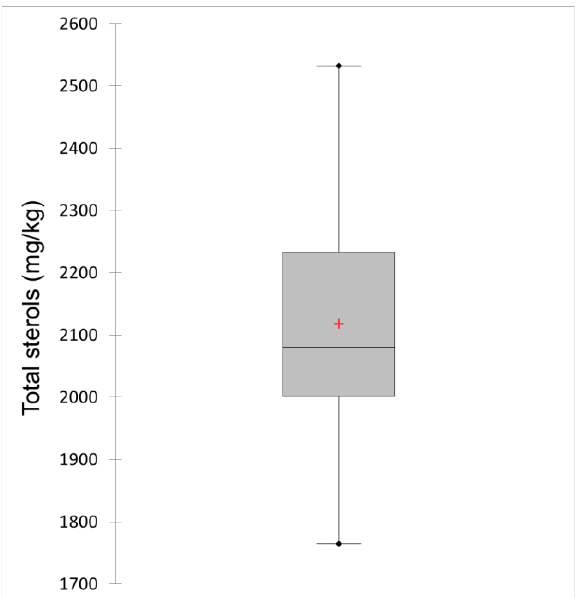
Figure 1. Box-whisker plot of total sterol content in the analysed oil samples labelled as pumpkin seed oils ( n = 25).